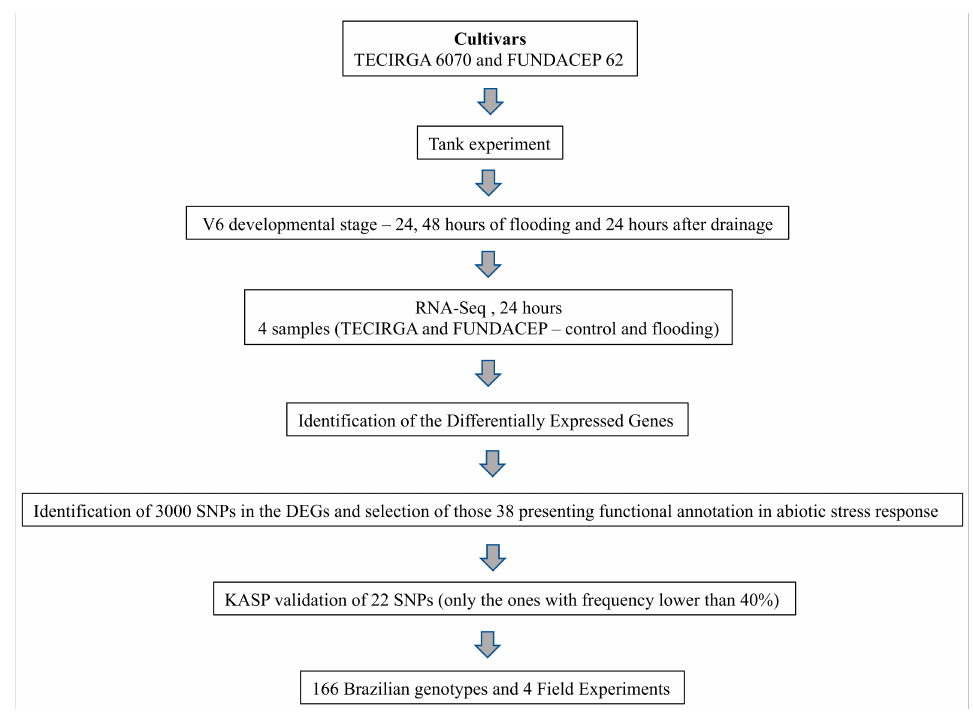
Figure 4. Experimental